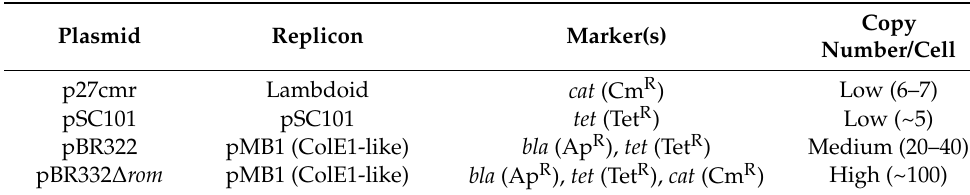
Figure 2. Schematic representation of genomic regions of E. coli strains hfq + , ∆ hfq :: kan , and ∆ CTR hfq :: kan . Whole length hfq gene, and its truncated form, hfq’ , coding for intact NTR, are shown as blue arrows. The kan gene, responsible for kanamycin resistance, is marked by red arrow. The scheme is not drawn to scale. Table 1. Plasmids used in this work.